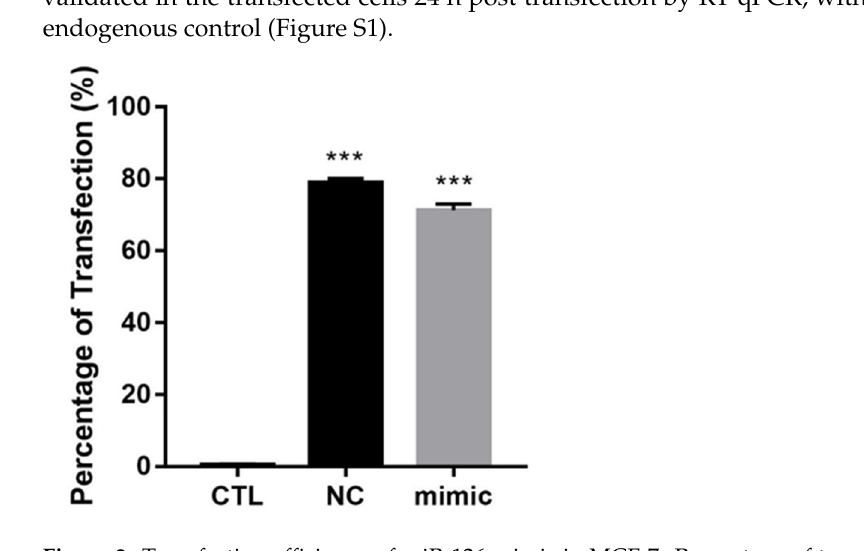
Figure 3. Effect of miR-126 on cell proliferation and cell cycle progression. ( A ): Proliferation of miR- 126 mimic compared to NC-transfected cells by MTT assay at 48 and 72 h post transfection (n = 3). ( B ): Cell Cycle Analysis of the transfected cells by PI staining at 24 h (n = 3) and 48 h (n = 3) post transfection. ( C ): Representative figure of the flow cytometric analysis of the cell cycle 24 h post transfection. Error bars represent SEM. * denotes p < 0.05. 2.4. Decreased Mammosphere-Forming Ability of MCF-7 upon Overexpressing miR-126 To determine the effect of miR-126 on the sphere formation of MCF-7, a mam- mosphere formation assay was performed (Figure 4A). Our results showed that there was a significant decrease in the mammosphere-forming efficiency (MFE) of miR-126–trans- fected MCF-7 ( p = 0.0301) when compared to NC-transfected cells of the primary genera- tion. To check the effect of miR-126 on the self-renewal of the cells, spheres were propa- gated. Again, miR-126 was able to reduce the MFE in MCF-7 ( p = 0.0145) of the secondary generation (Figure 4B).